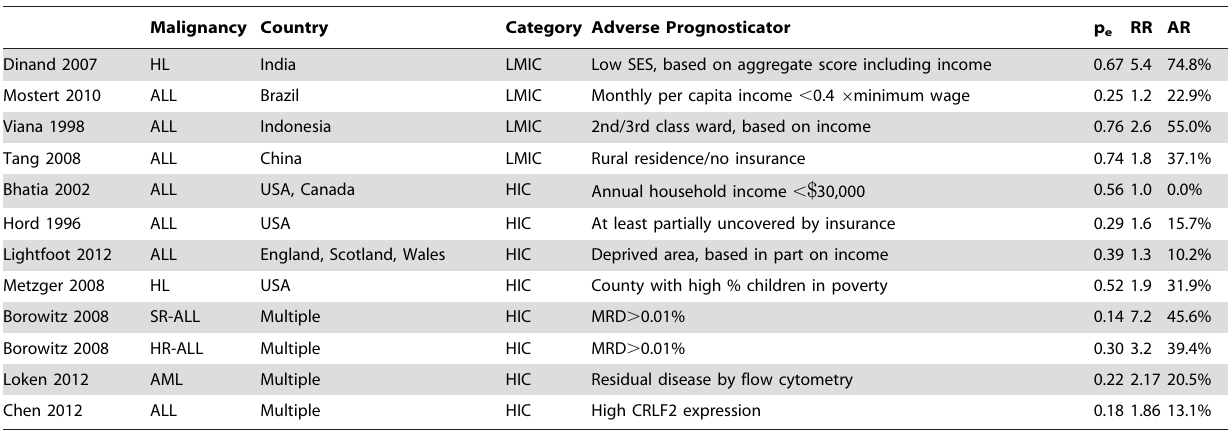
Table 5. Proportion of adverse outcomes (attributable risk) due to poor socioeconomic prognosticators in studies of the effect of dichotomous measures of income and insurance in acute lymphoblastic leukemia and Hodgkin lymphoma, as well as of selected biologic prognosticators by way of